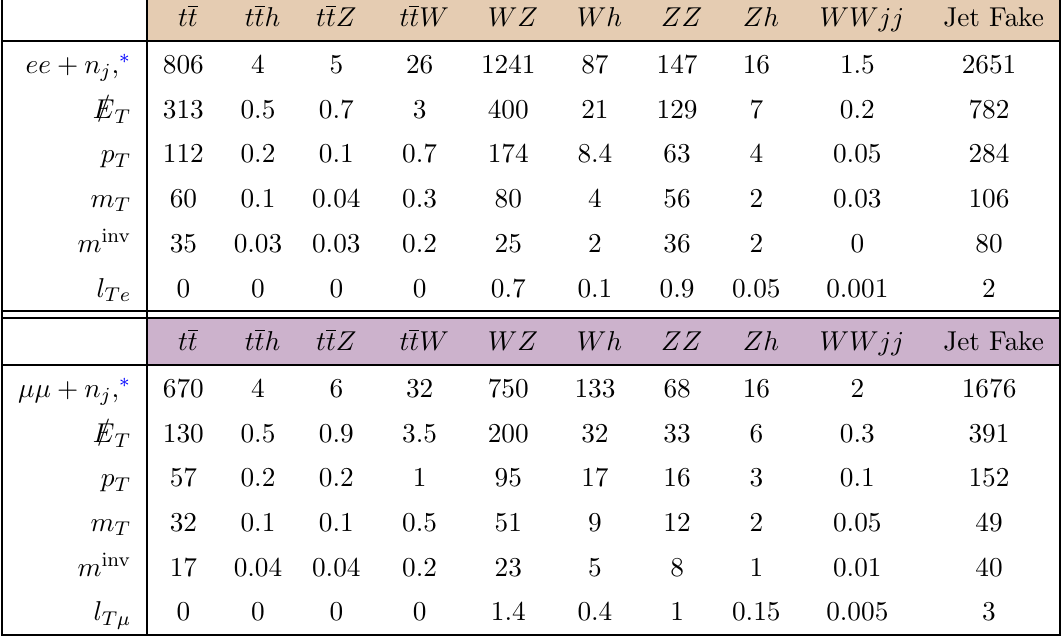
(cid:3) The same-sign lepton selection includes p T trigger for di-muons at 10 GeV and di-electrons at 12 GeV. Table 1 . SM background processes at 13 TeV and 100 fb (cid:0) 1 for the same-sign tight di-leptons and n j = 1{3 (cid:12)nal state, see text for the cut descriptions.